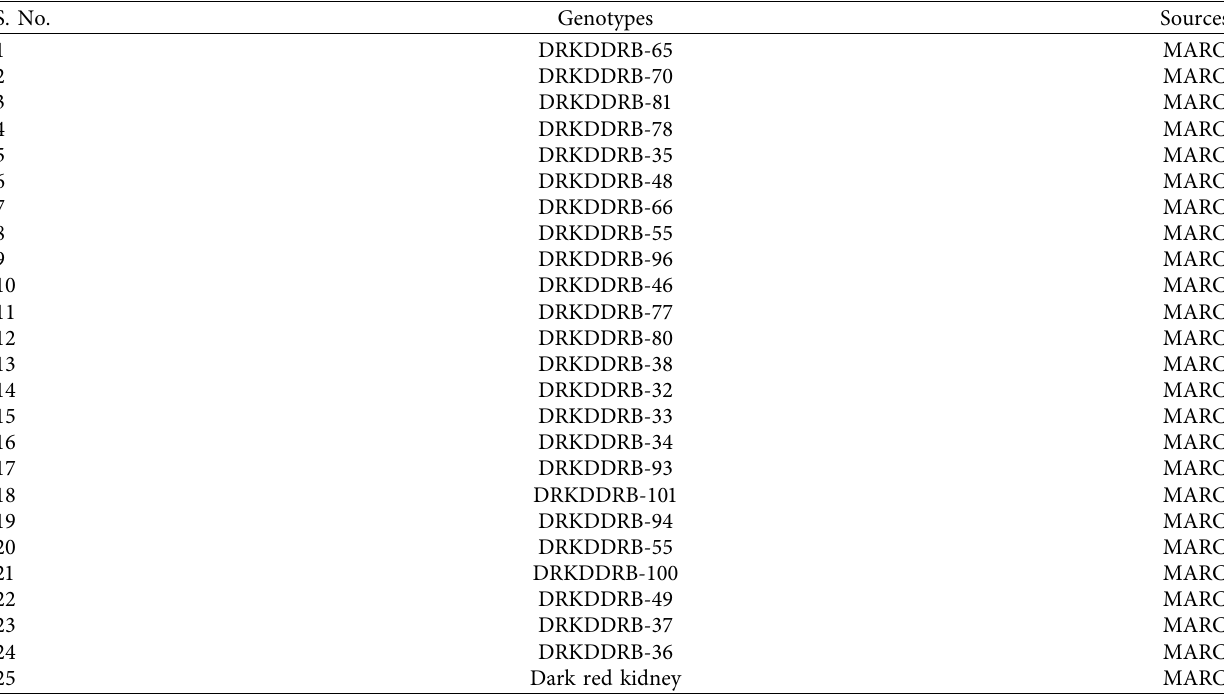
Table 1: List of common bean genotypes used in the